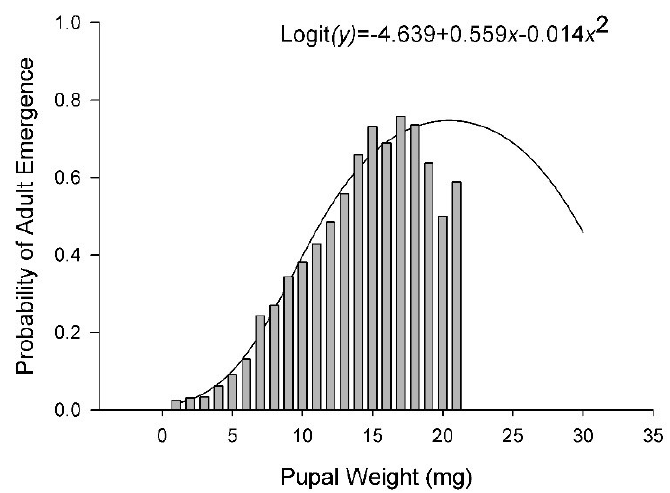
Figure 5. Probability of successful adult emergence relative to pupal weight. Solid line represents the logistic model. Bars represent observed data. Data are from all temperatures and diets combined.